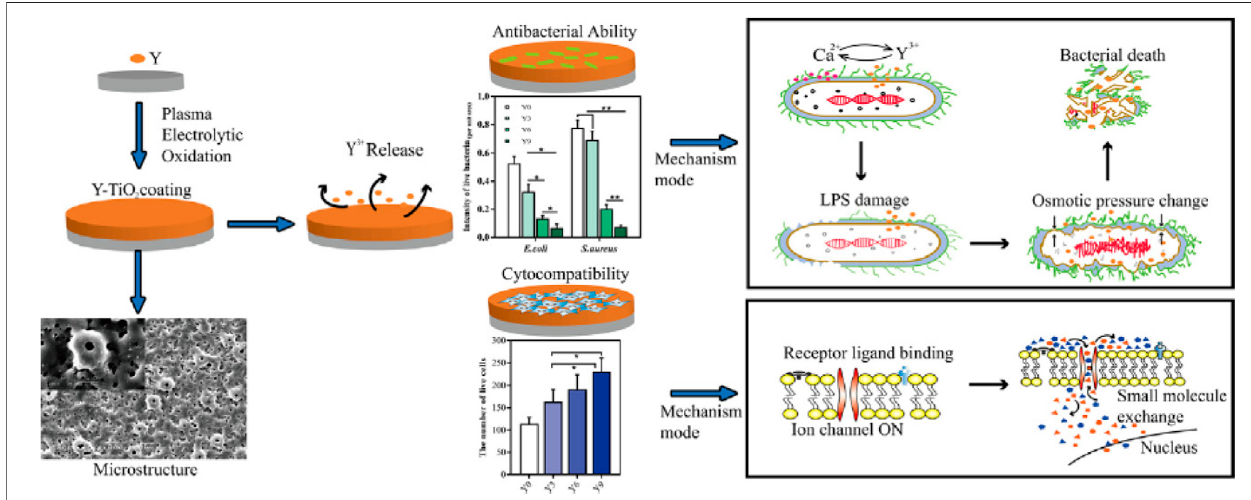
FIGURE8| Preparation fl owchartandantibacterialmechanismofY-dopedTiO Elsevier Ltd.